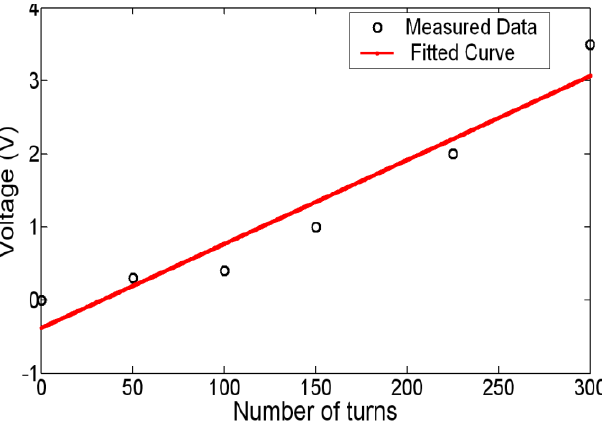
Figure 6: Plot showing the linear relationship between number of turns of coil and the output peak to peak